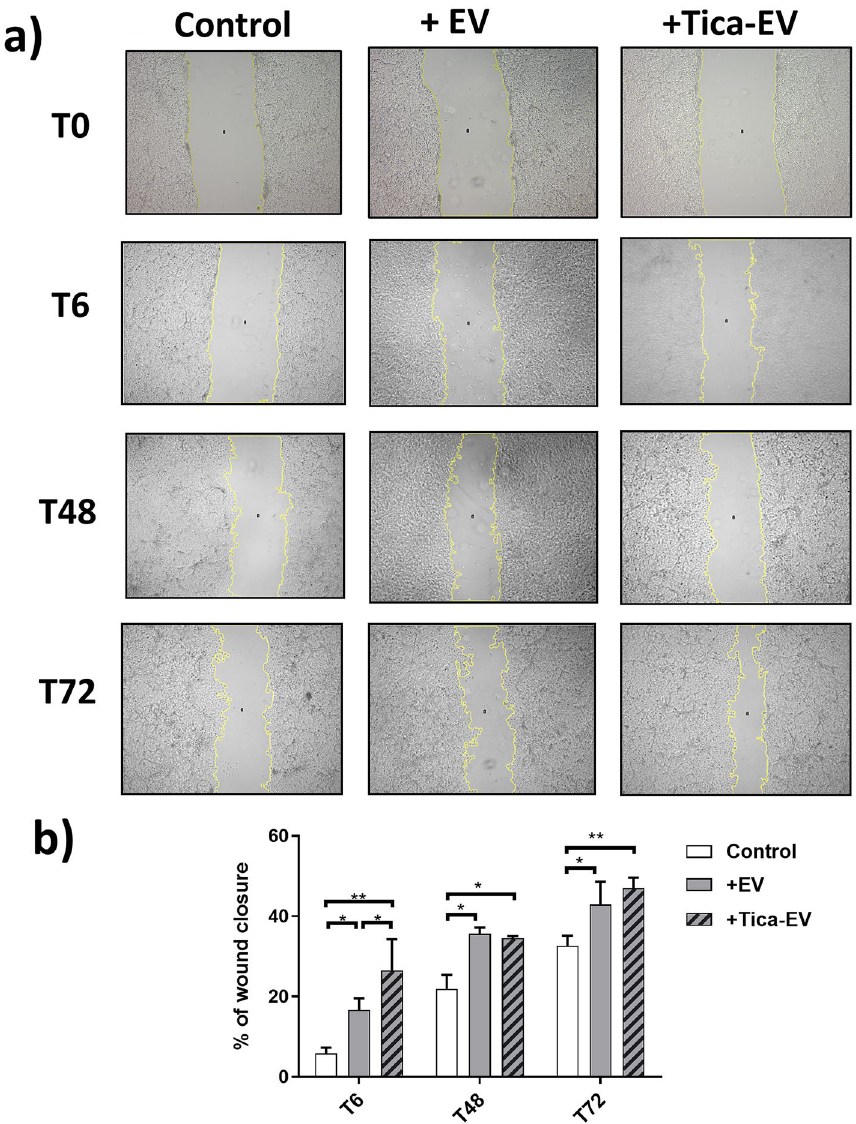
Figure 3. Effects of ticagrelor (Tica, 1-µM) pretreated H9c2-derived EV (+ Tica-EV) on cell migration by wound healing analysis. ( a ) The HUVEC cells were seeded on a 6-well plate and incubated either with control (+ EV) or ticagrelor-pretreated H9c2-derived EVs (Tica-EV). Representative images show that Tica-EV treatment causes a significant increase in wound closure ( b ) The percentage of wound closure is analyzed by ImageJ and 6th h, 48th h, and 72nd h of incubation. Data are expressed as the mean ± SD (n = 3). *p < 0.05, **p < 0.01, n.s.: not